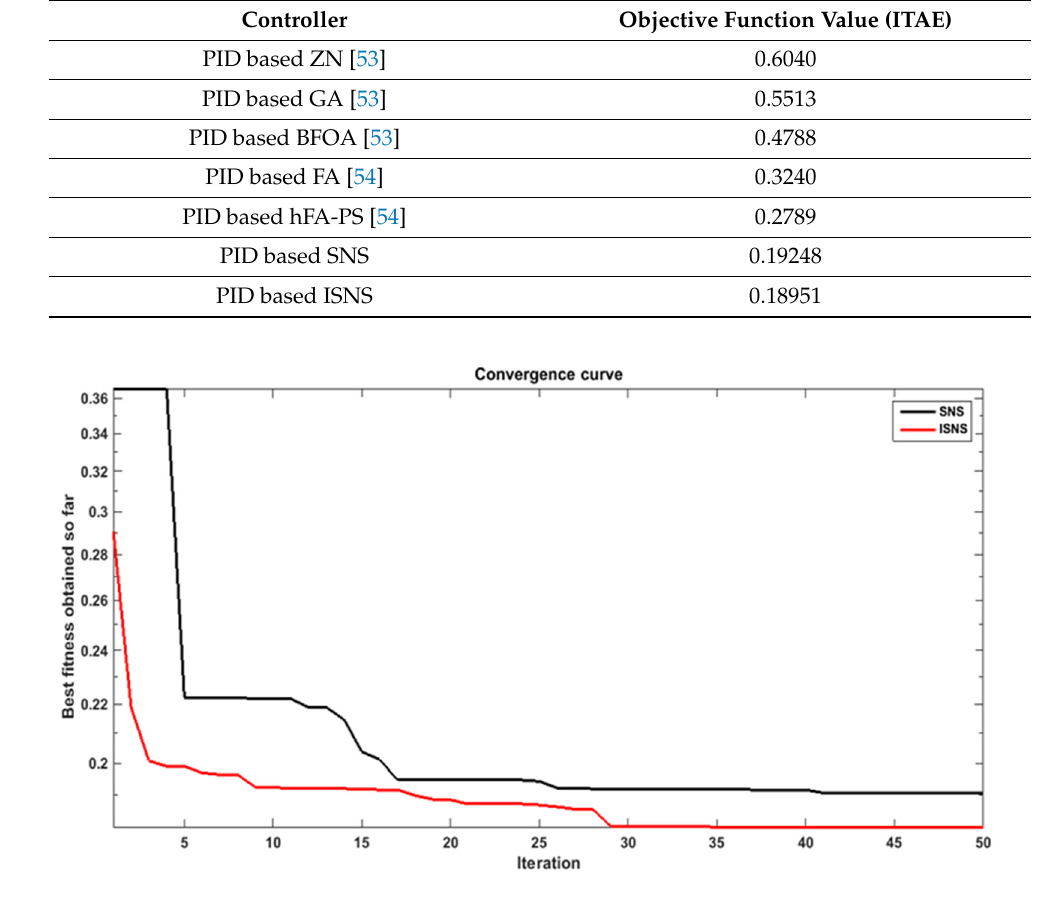
Figure 13. The convergence cure of the PID controller based on (SNS, and ISNS) algorithms.